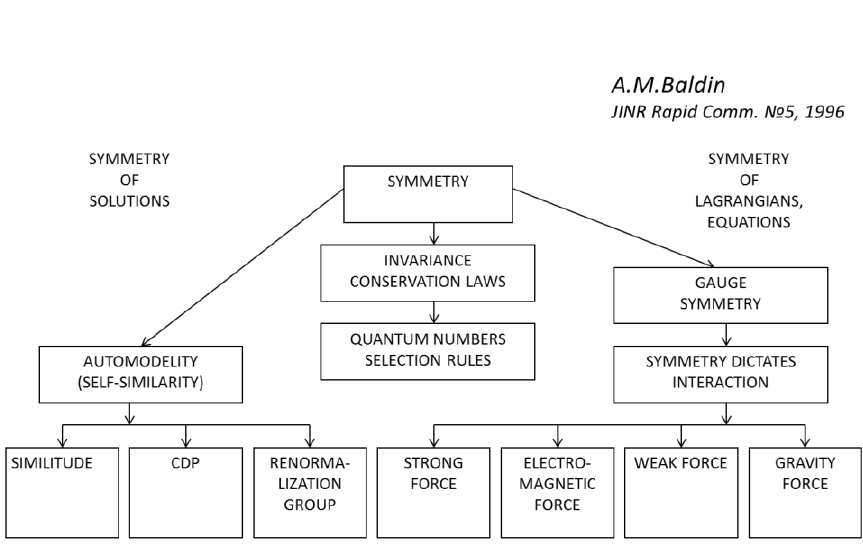
Figure 1. Symmetry includes symmetry of solutions and symmetry of equations [1] Surely, the nature of elementary particles was of great interest, too